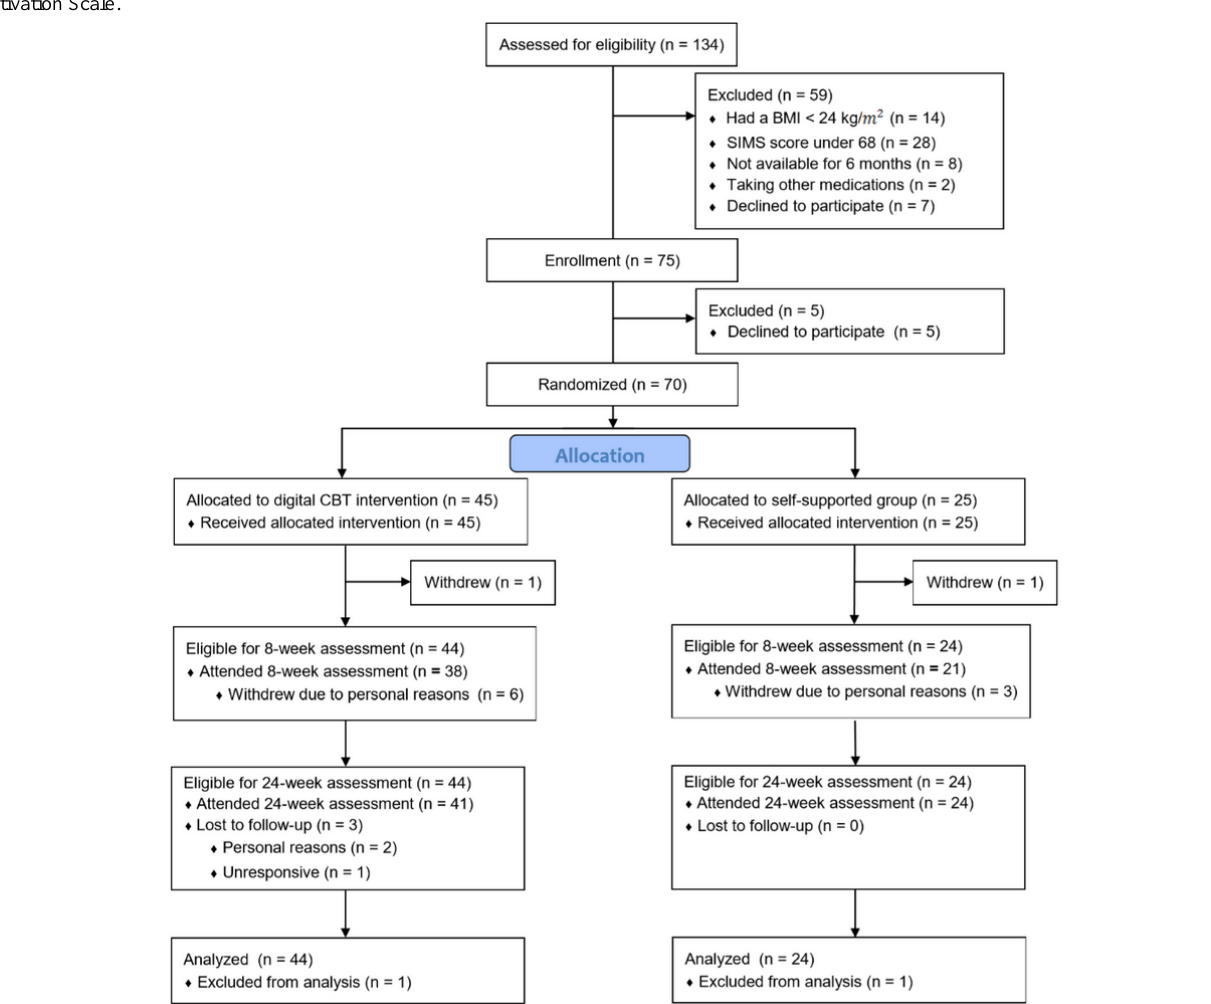
Figure 1. Digital cognitive behavioral therapy (CBT) CONSORT (Consolidated Standards of Reporting Trials) flow diagram. SIMS: Situational Motivation